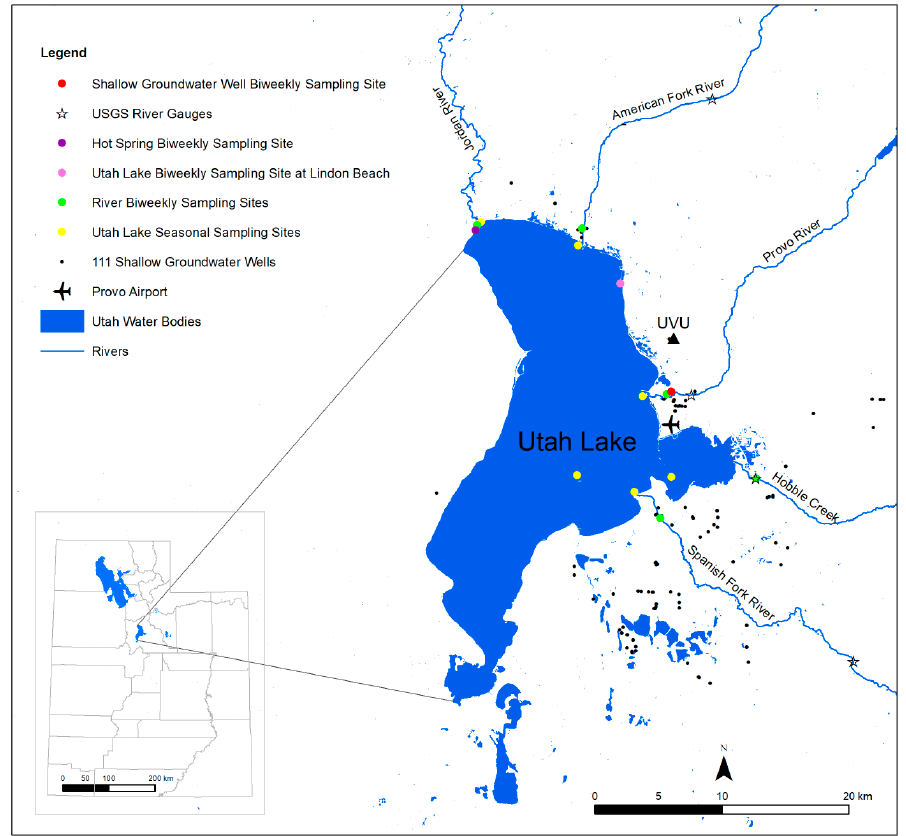
Figure 3. Location map showing the sampling sites of the biweekly samples, of the seasonal samples, of the meteoric precipitation (Utah Valley University: UVU), and of the 111 shallow groundwater wells. The figure also shows the location of the Provo Airport weather station (the source of the climate data) and of the USGS river gauges (the source of the discharge data).